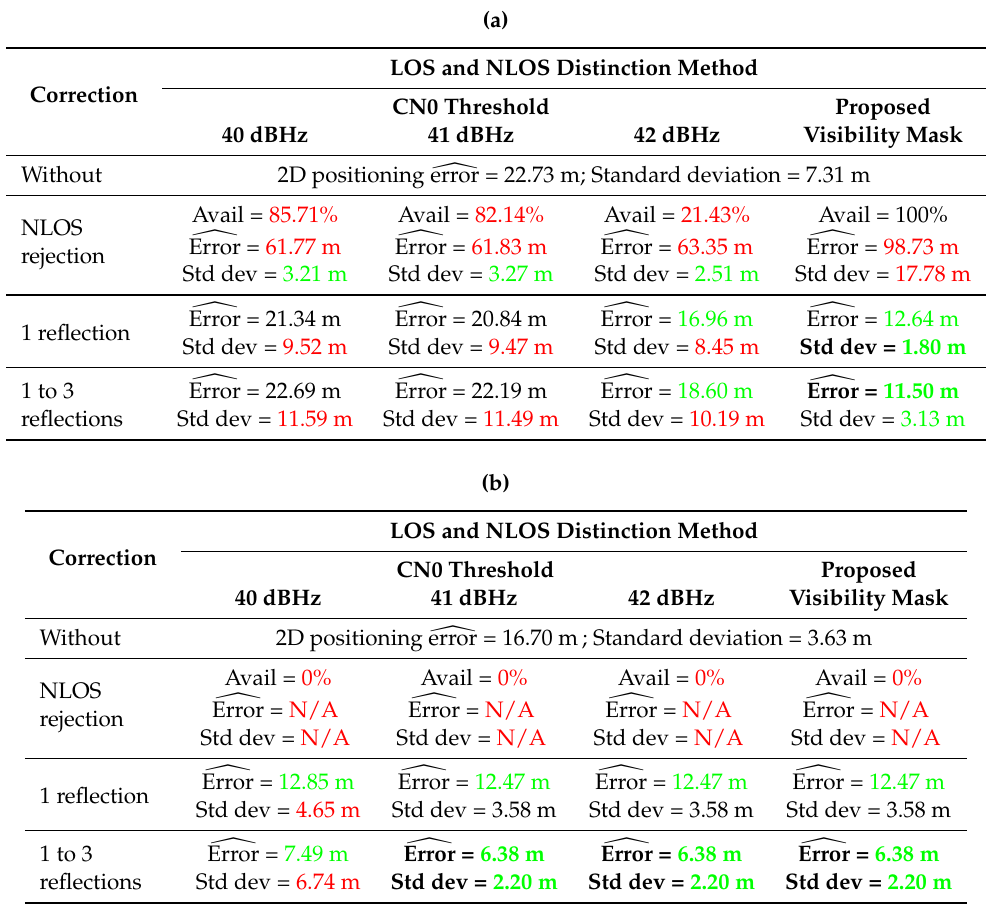
Table 4. 2D localization evaluation with NLOS pseudoranges correction for presented acquisitions. (cid:91) (cid:91) Scene’s best scores are in bold. Error is red when superior to Error without correction, black when (cid:91) (cid:91) similar at ± 10% to Error without correction and green when inferior to Error without correction. The same applies for standard deviation. NLOS rejection decreases availability, availability rate is red when inferior to 90%. ( a ) Cap3/0900; ( b )